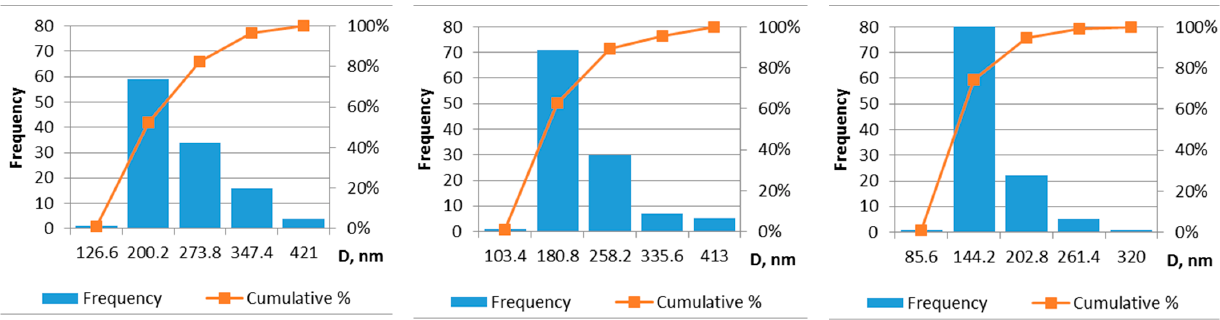
Figure 8. Histograms of electrospun fiber diameters: sample 6PVA125 electrospun using cylinder- type electrode (left); sample 6PVA130 electrospun using cylinder-type electrode (center); sample 6PVA130 electrospun using wire-type electrode (right).